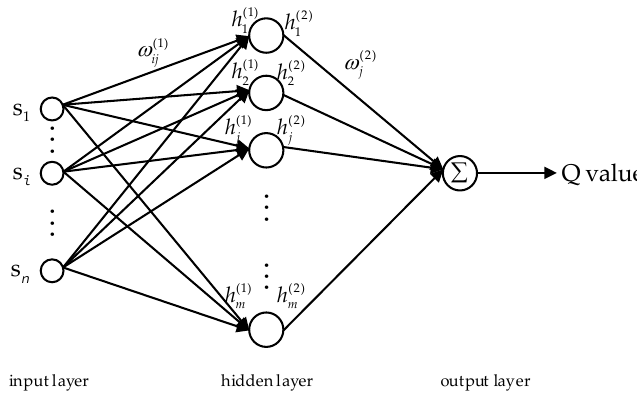
Figure 4. Diagram of a multi-layer neural network.